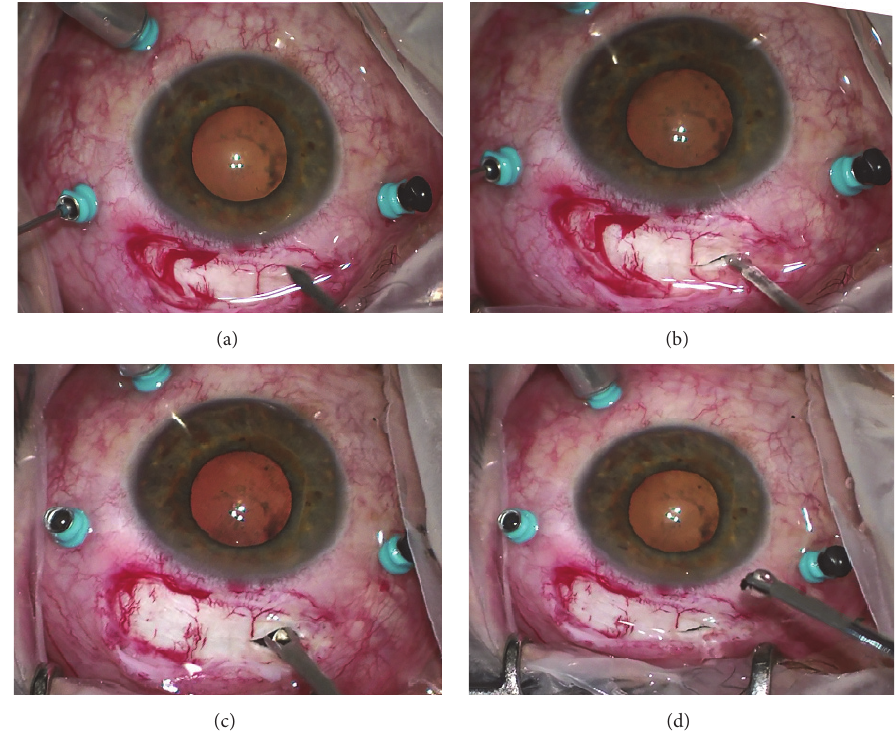
Figure 3: Intraoperative photographs (inverted image as seen by the surgeon). (a-b) Linear pars plana scleral access with max length of 3 mm is realized at 12 hours preserving the sites of trocars. (c-d) A metallic foreign body is extracted through a pars plana sclerotomy by basket forceps to prevent